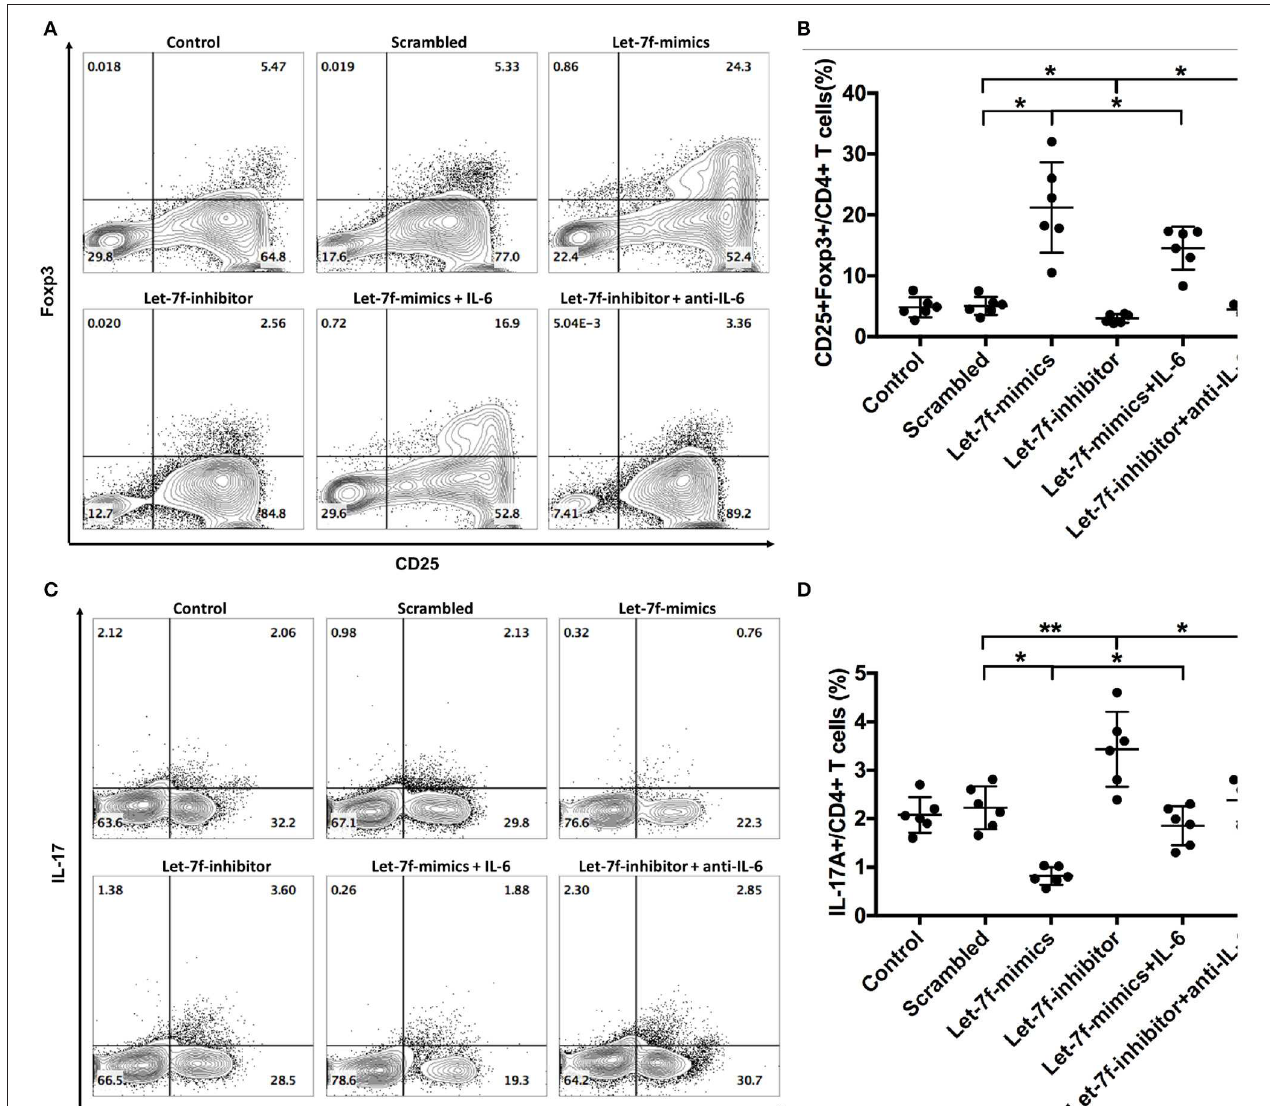
FIGURE 4 | Let-7f upregulates immunoregulatory effects of BM-MSCs in vitro . (A,B) Percentages of T reg cells (CD25 + Foxp3 + /CD4 + T cells) after co-culturing of pre-stimulated naïve T cells with let7f-related oligonucleotide transfected BM-MSCs with or without the presence of recombinant human IL-6 (50ng/ml) or anti-human IL-6 antibody (30 µ g/ml). (C,D) Percentages of Th17 cells (IL-17A + /CD4 + T cells), after co-culturing of pre-stimulated naïve T cells with let7f-related oligonucleotide transfected BM-MSCs with, or without the presence of recombinant human IL-6 (50ng/ml) or anti-human IL-6 antibody (30 µ g/ml). All data are mean ± SEM. n = 6, * P < 0.05, ** P <